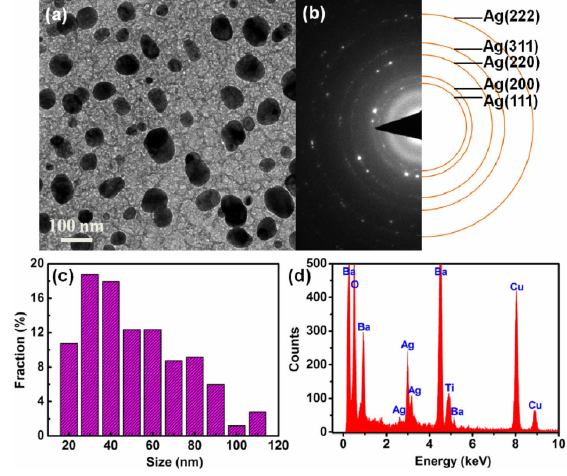
Fig. 2 (a) Bright field TEM micrograph, (b) SAED pattern, (c) particle size distribution histogram, and (d) EDS spectrum of the Ag 25 /BTO thin